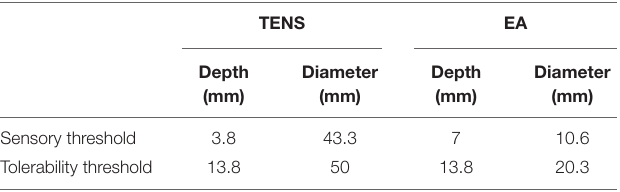
TABLE 5 | The depth and a cross-sectional diameter of electric field gradient at different sensorial